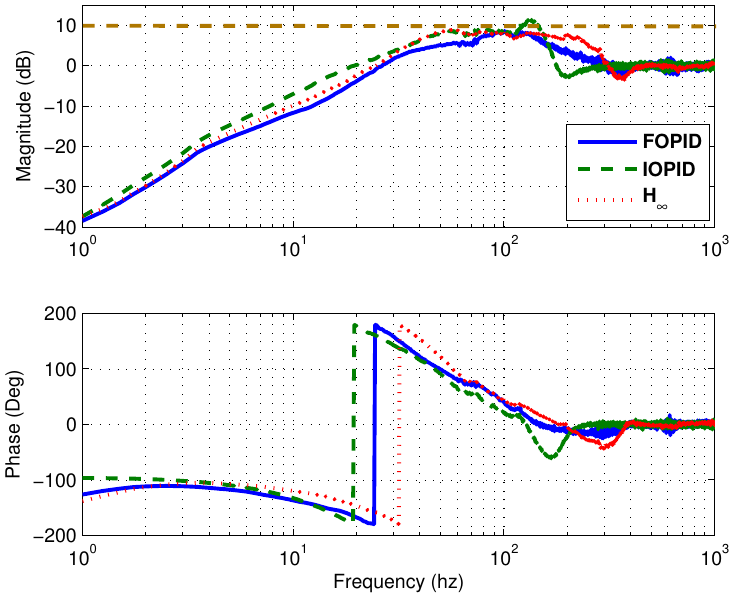
Figure 31. Bode plots of the thrust AMB sensitivity function.